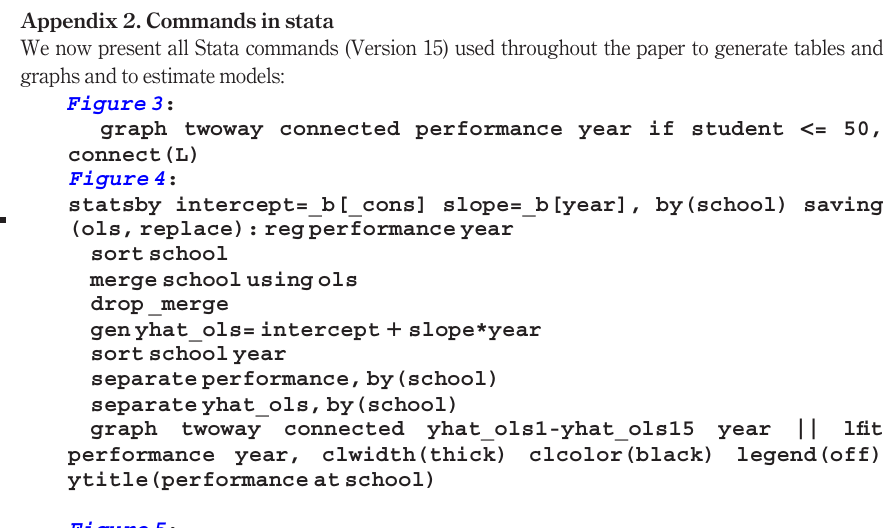
Figure 5 : xtmixed performance || school: || student:, var nolog reml